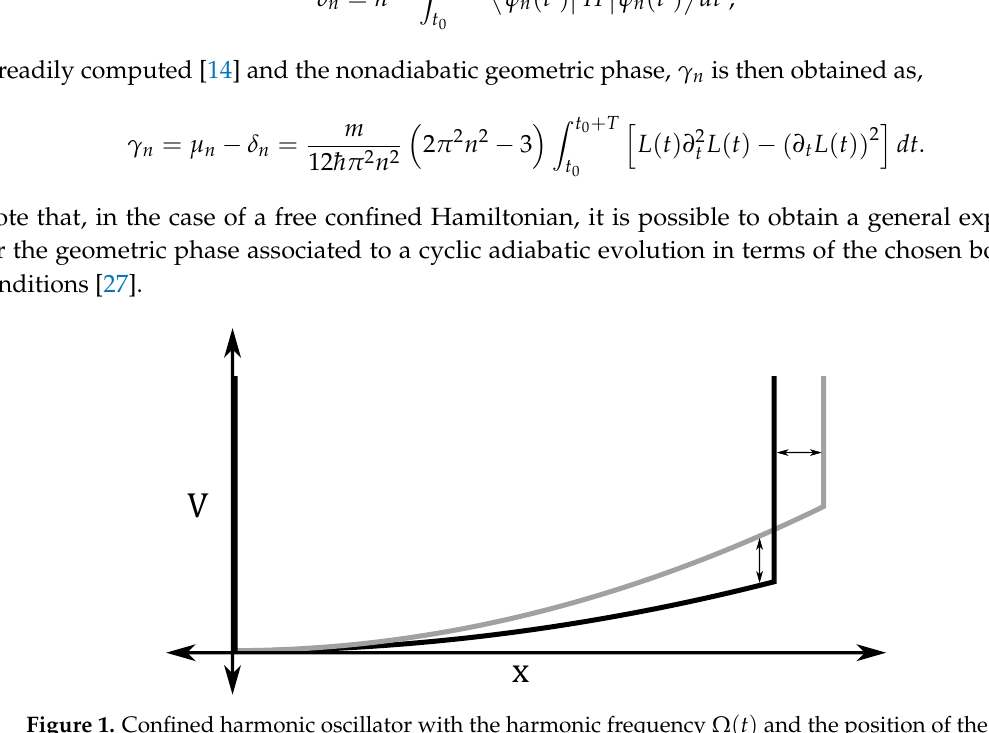
Figure 1. Confined harmonic oscillator with the harmonic frequency Ω ( t ) and the position of the left wall L ( t ) periodic functions of